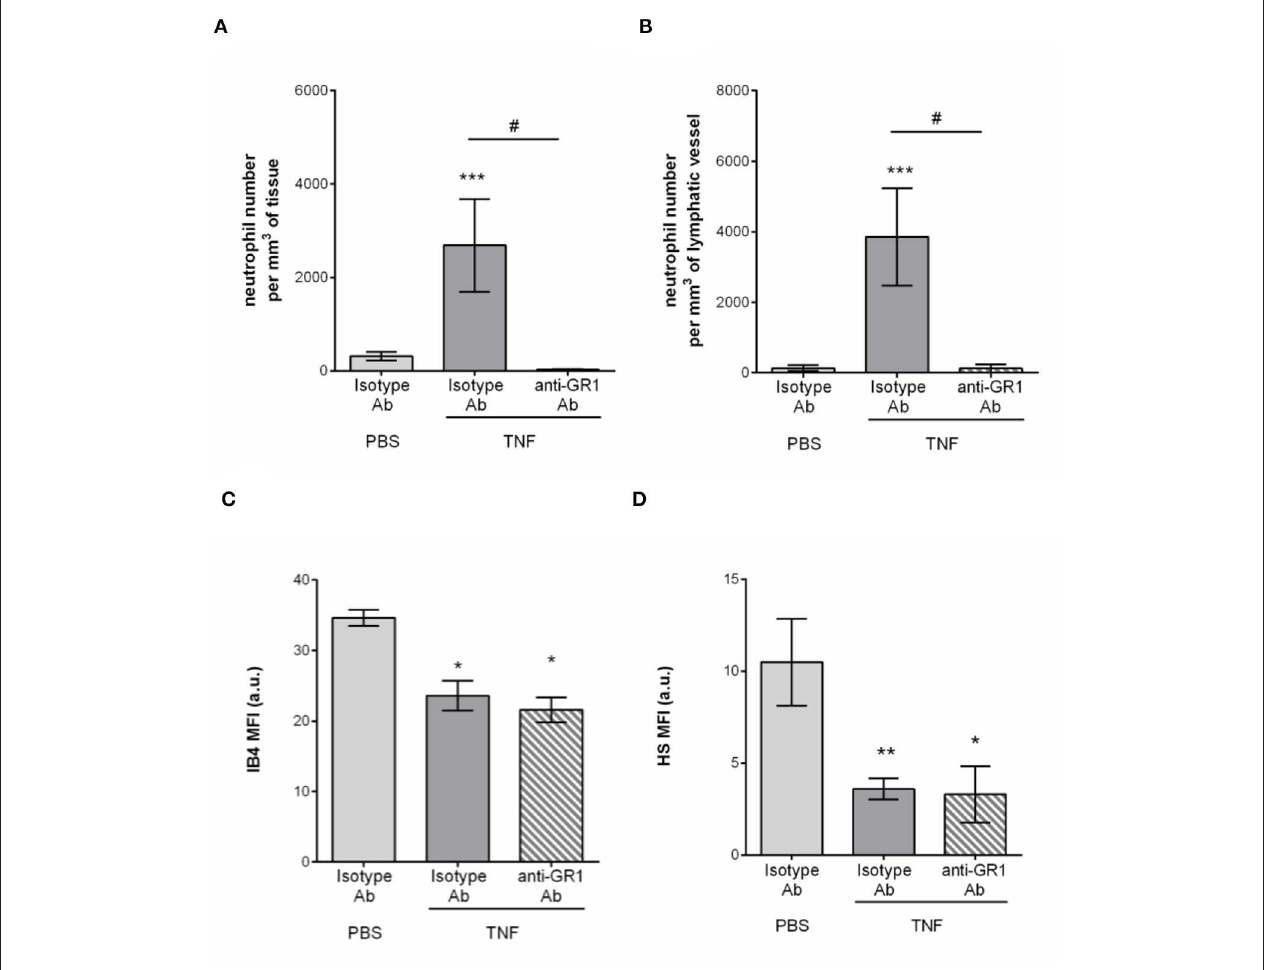
FIGURE 6 | Neutrophil-independent remodeling of initial lymphatic glycocalyx upon TNF-induced inflammation. Circulating neutrophils were depleted via a daily intraperitoneal (i.p.) injection of the anti-GR1 depleting antibody (25 µ g) for 3 days prior to the induction of the inflammatory response. Inflammation of the cremaster muscles of WT mice was induced by the intrascrotal (i.s.) injection of TNF (300 ng) for 16h. Non-depleted control mice received i.p. injections of an isotype control antibody; and unstimulated animals were injected i.s. with PBS. Two hours before the end of the inflammation period, mice were i.s injected with fluorescently labeled IB4/anti-HS Ab in conjunction with a non-blocking anti-LYVE-1 Ab to visualize the glycocalyx moieties and the lymphatic vessels, respectively. At the end of the inflammatory period, mice were sacrificed and their cremaster muscles harvested, fixed, and fluorescently-labeled with an anti-MRP14 Ab to detect the neutrophils. Neutrophil migration responses were analyzed in 3D by confocal microscopy. Lymphatic glycocalyx mean fluorescence intensity (MFI) was quantified with an isosurface generated on the lymphatic vessels (LYVE-1 + vessels) using IMARIS software. (A) Number of neutrophils migrated into the tissue. (B) Number of neutrophils within the cremaster initial lymphatic vessels. (C) Mean fluorescence intensity (MFI) of IB4 staining on lymphatic vessels. (D) Mean fluorescence intensity (MFI) of anti-HS Ab staining on lymphatic vessels. Results are from at least 3 animals per group. Statistically significant differences between stimulated